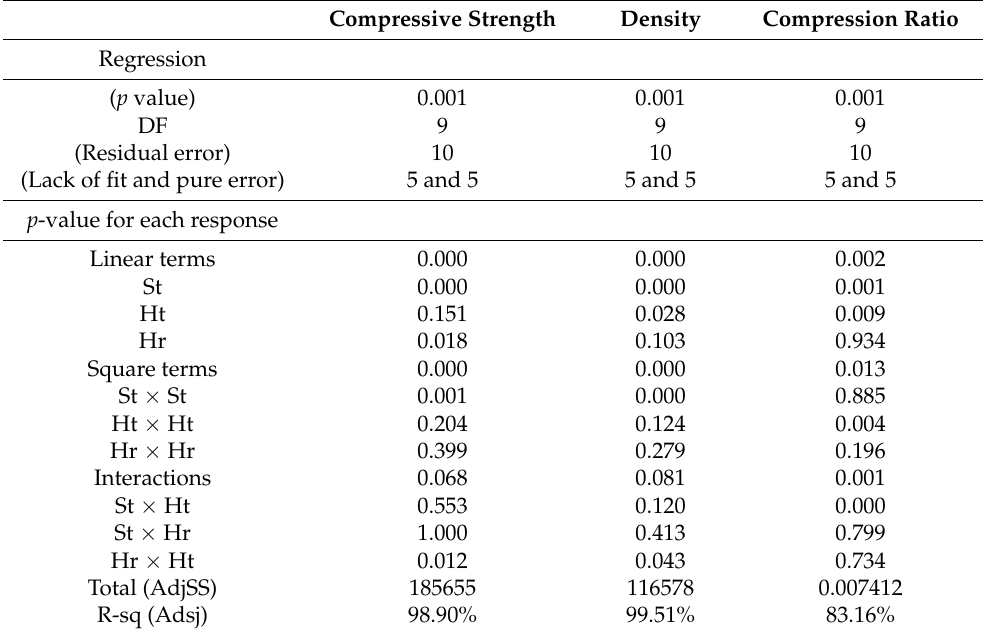
Table 5. ANOVA results of CCDs